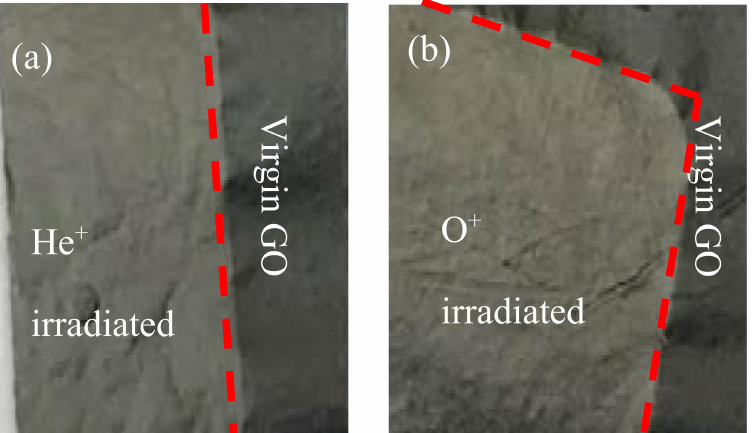
Figure 1. Magnified 5 × optical image of the interface between virgin GO and the irradiated one by He + ions ( a ) at the 5 × 10 13 ions/cm 2 fluence and by O + ions ( b ) at the 5 × 10 12 ions/cm 2 fluence. It is possible to note how the black color in the virgin GO turns into a metallic